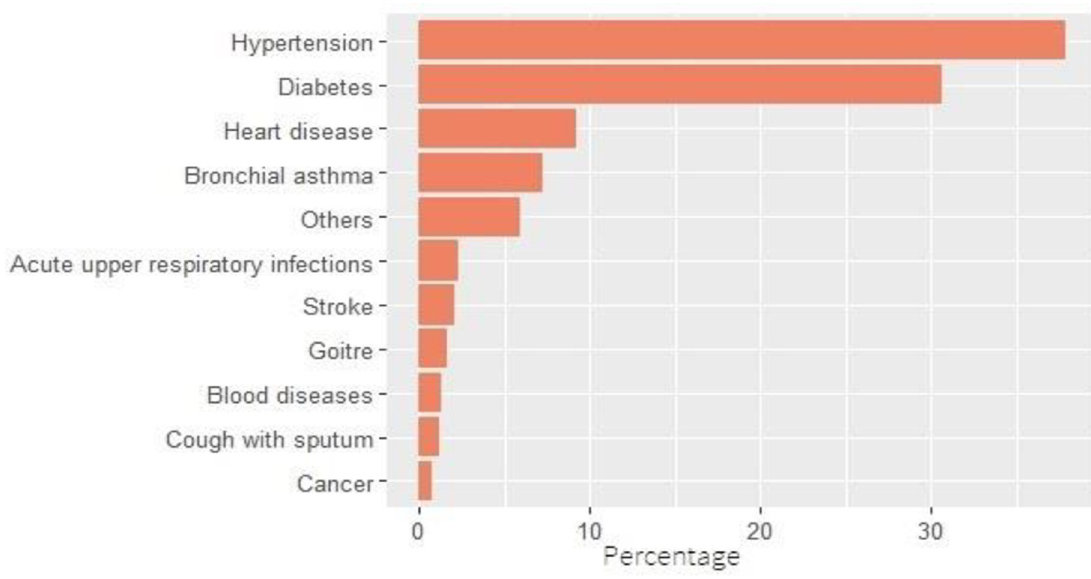
Fig 1. Percentage distribution of chronic diseases among ageing population, India, 2017–18 (based on 75th round of NSS).